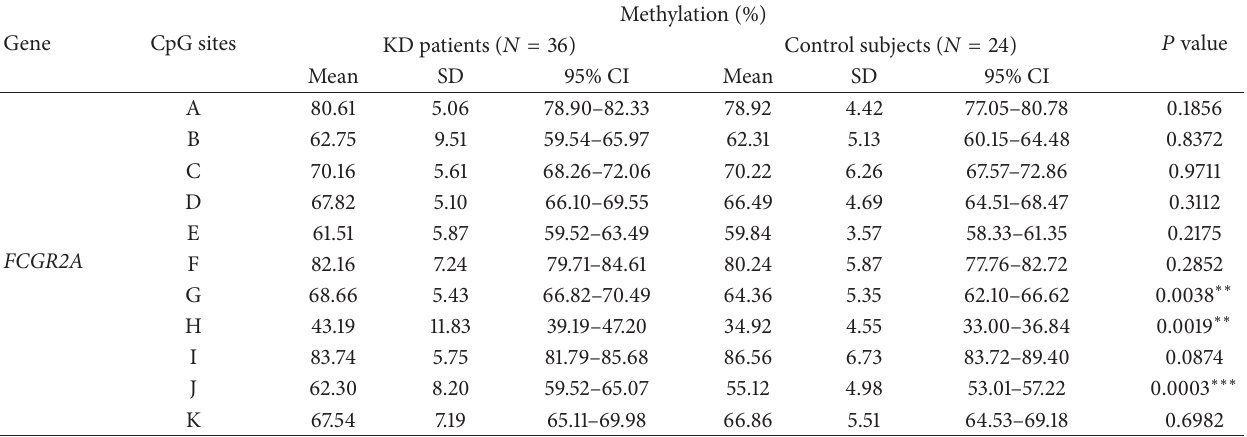
The statistical significance ∗∗ 𝑃 < 0.01 , ∗∗∗ 𝑃 < 0.001 .